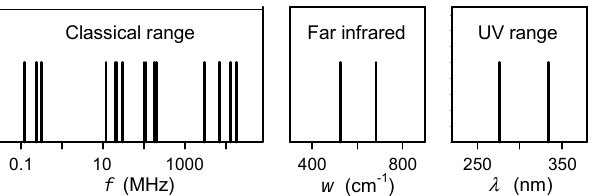
Figure 1. Measured resonant frequencies f , wavenumbers w and wavelengths λ of isolated micro- tubules in the radio frequency, far infrared, and UV frequency ranges (published by Sahu et al. [24]).